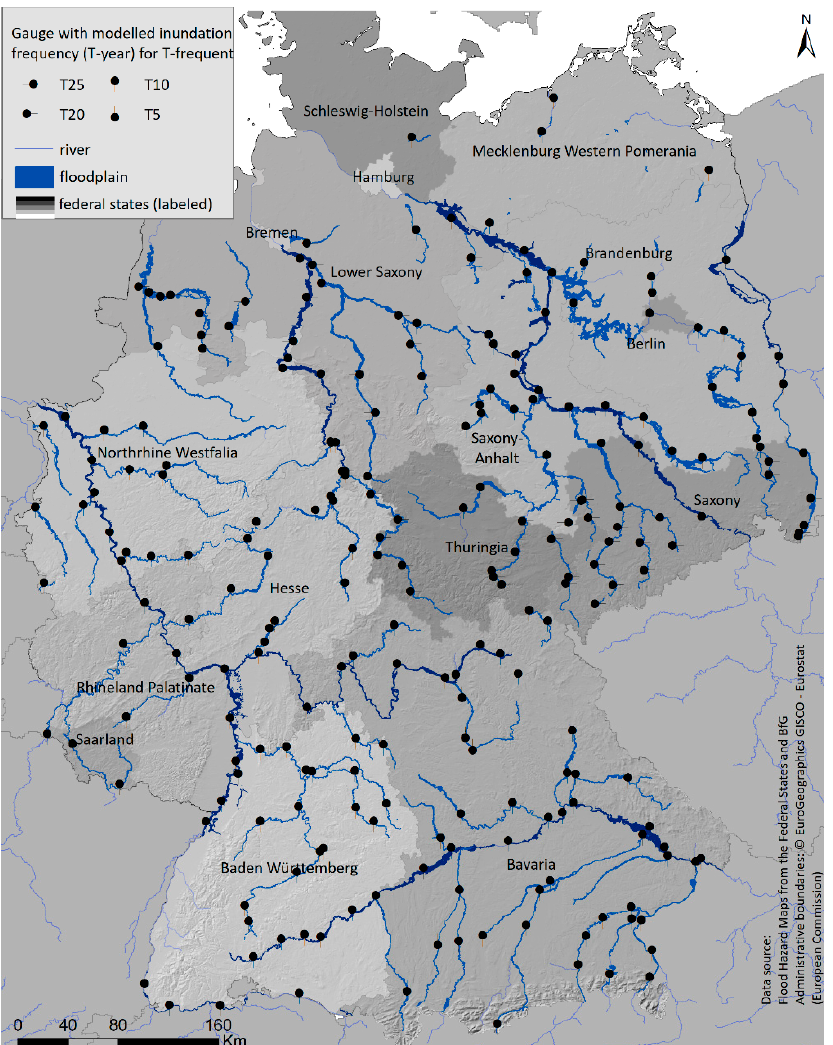
Figure 2. Overview of analyzed rivers and their floodplains in Germany. Federal states are displayed in different colors. Floodplains of the main rivers Rhine, Danube, Weser, Elbe, Ems and Oder are colored darker than the other rivers.